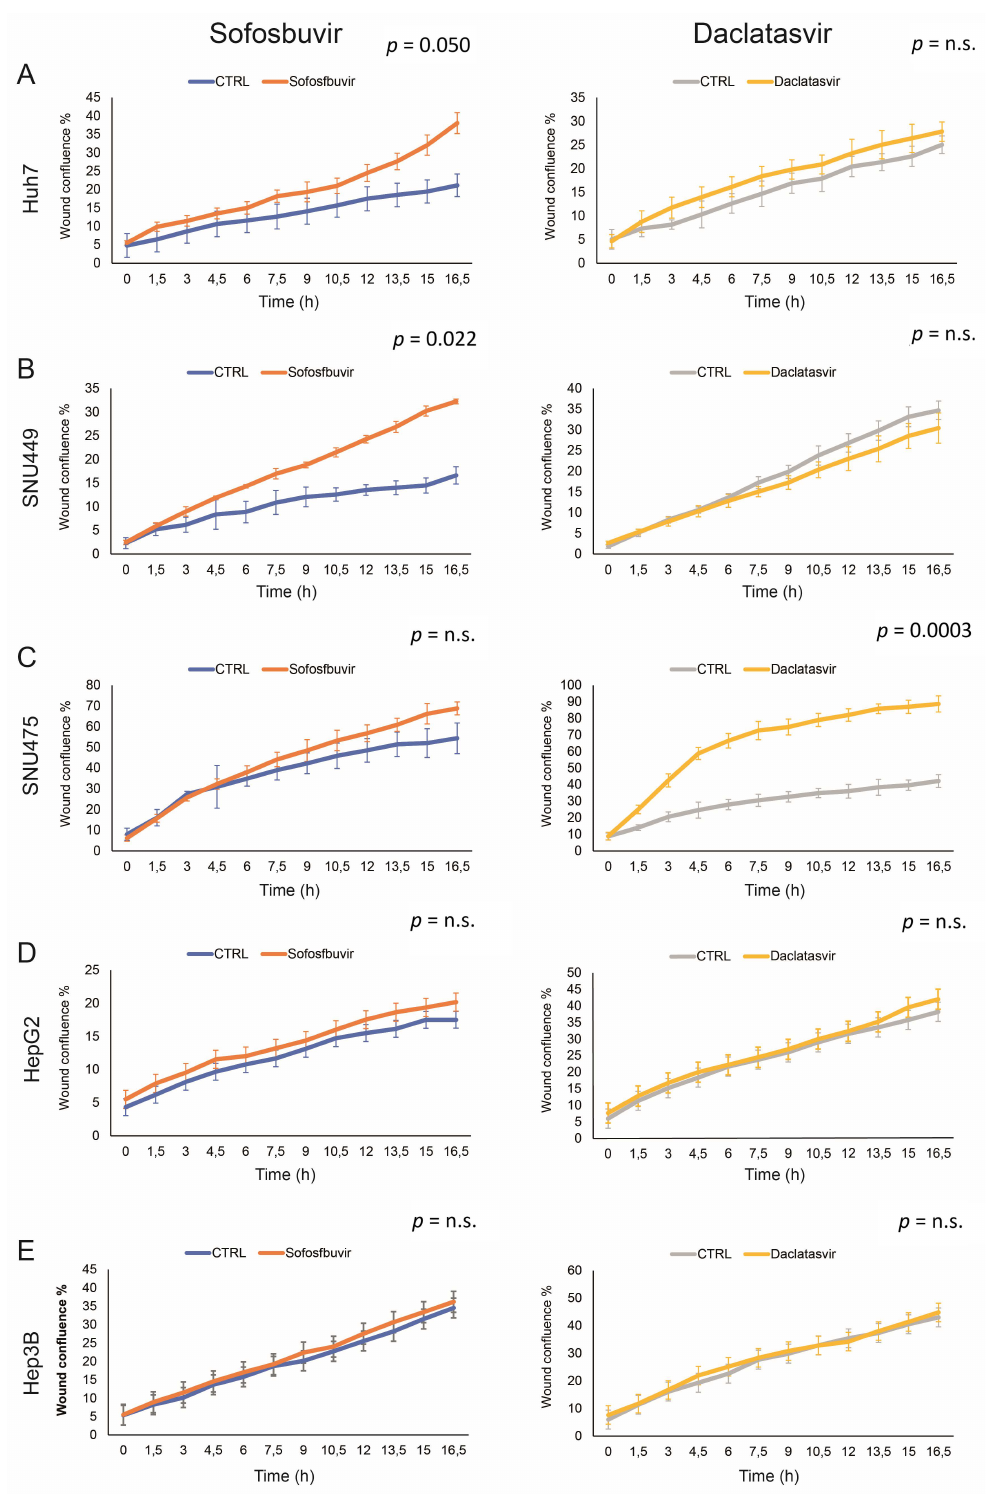
Figure 2. E ff ects of DAAs on cell migration of HCC-derived cell lines. Cell migration was investigated by the Incucyte Live-Cell Analysis System in ( A ) Huh7, ( B ) SNU449, ( C ) SNU475, ( D ) HepG2 and ( E ) Hep3B cells following treatment with sofosbuvir (4 µ M) and daclatasvir (10 nM). Control cells were treated with matched DMSO concentrations, accounting for di ff erences observed in controls from the same cell line. n.s.: not